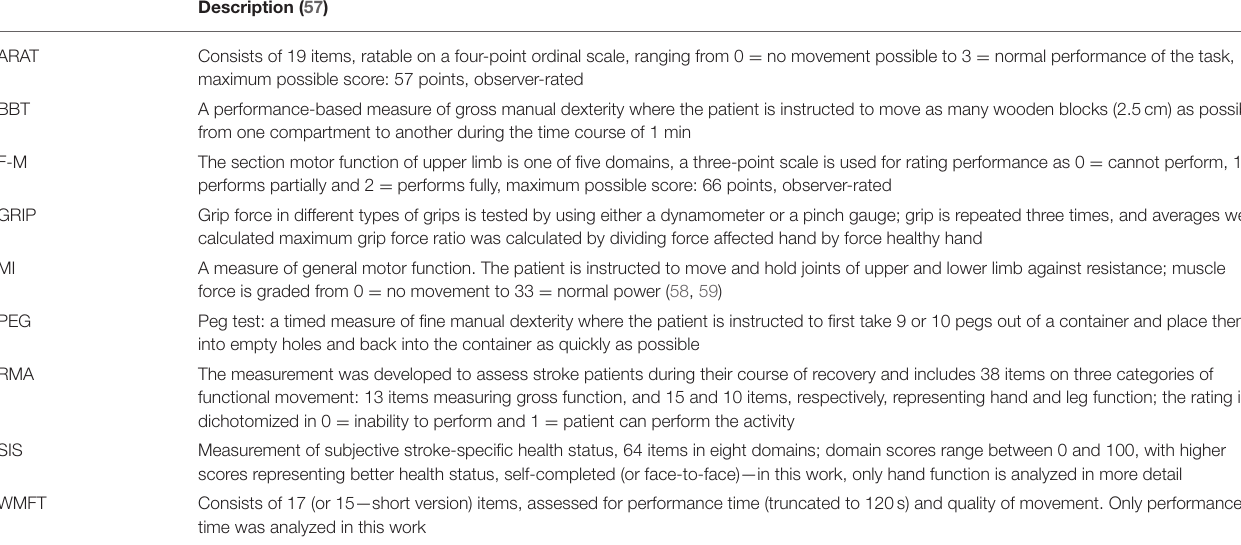
TABLE 4 | Most common assessments used in large stroke trials. Description (57) ARAT